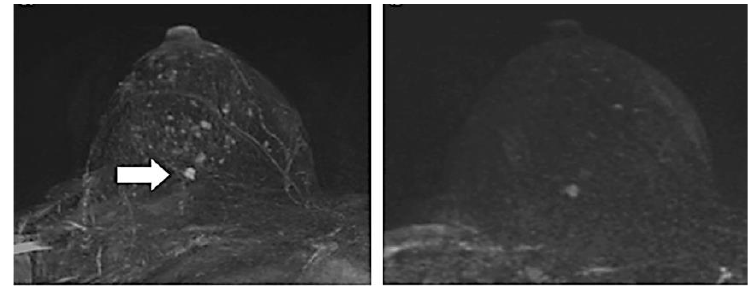
Figure 7. Typical finding of MRI-detected breast cancer (arrow)